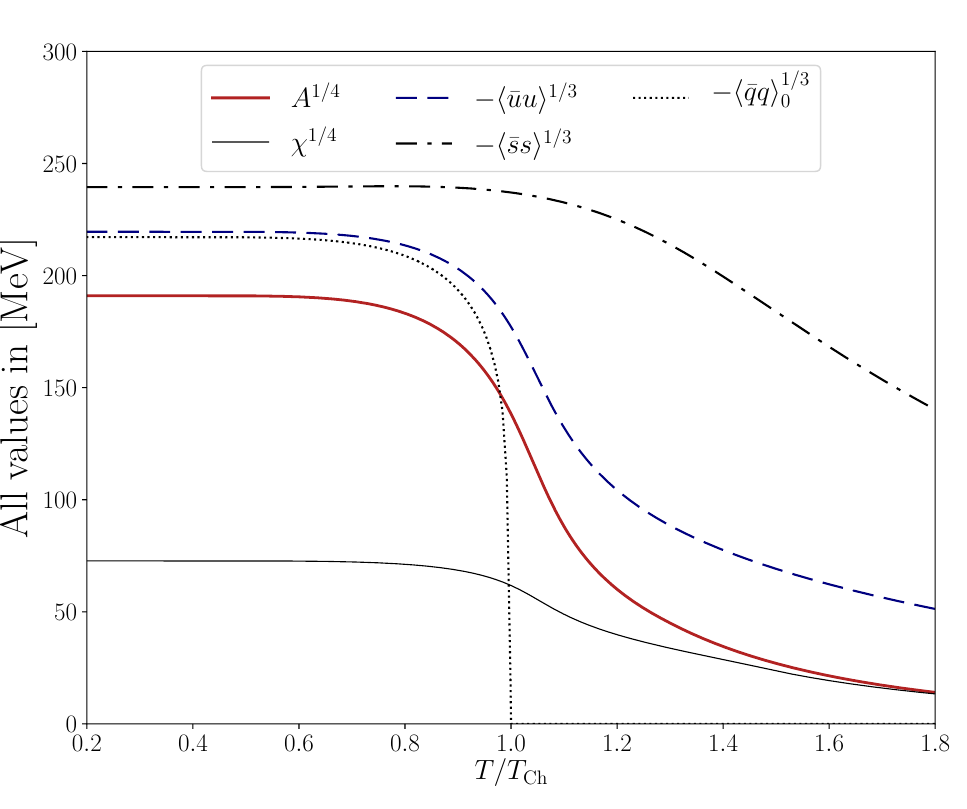
Figure 2. The relative-temperature T / T c dependences (where T Ch ≡ T c ) of (the 3rd root of the absolute value of) the q ¯ q condensates, and of (the 4th root of) the topological susceptibility χ ( T ) and the full QCD topological charge parameter A ( T ) . Everything was calculated in the isosymmetric limit using the separable rank-2 DSE model which we had already used in Refs. [17,31,48]. (See Appendix A for the model interaction form and parameters, and the first line of Table 1 for the numerical values of the condensates and χ at T = 0.) Only the chiral-limit condensate ⟨ ¯ qq ⟩ 0 ( T ) falls steeply to zero at T = T Ch , indicative of the second-order phase transition. This sharp transition would through (7) and (6) be transmitted to, respectively, the chiral-limit χ ( T ) and ̃ χ ( T ) , and ultimately to the η and η ′ masses in Ref. [48]. The highest curve (dash-dotted) and the second one from above (dashed) are (3rd roots of the absolute values of) the condensates ⟨ ¯ ss ⟩( T ) and ⟨ ¯ uu ⟩( T ) , respectively. Their smooth crossover behaviors carry over to χ ( T ) and A ( T ) through Equations (9) and (8), respectively, leading to the empirically acceptable predictions [17] for the T -dependence of the η and η ′ masses. It turns out that χ ( T ) (9) also gives the smooth crossover behavior also to the T -dependence of the axion